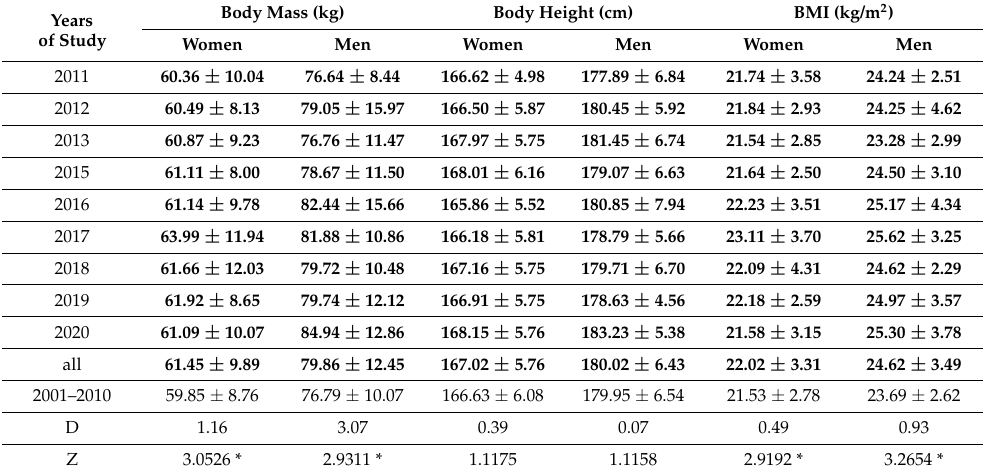
Table 2. Statistical characteristics (mean ± SD) of body mass, height and BMI in participants.